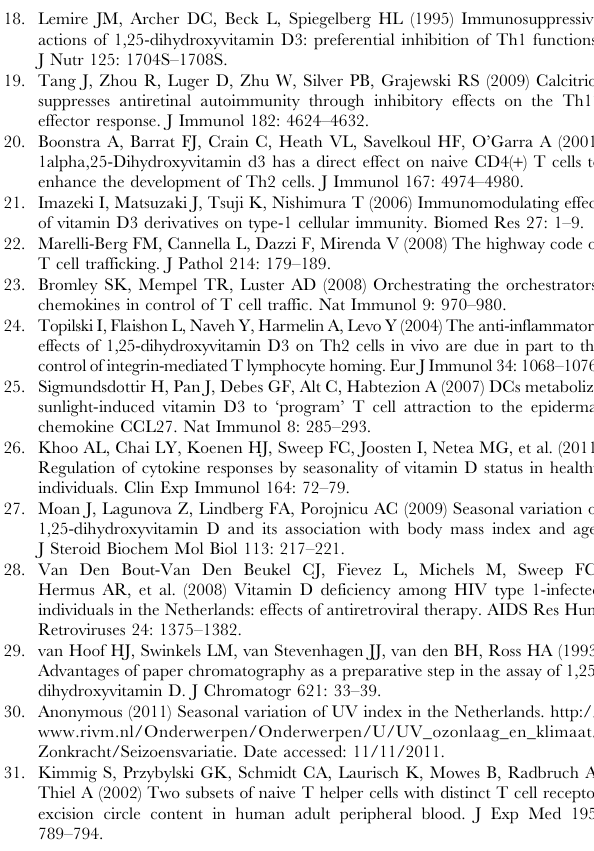
Figure S1 Gate setting for CD4 + and CD8 + T cells gated on CD45 + cells; and CD4 + CD45RA + T cells, CD4 + CD45RO + T cells and CD4 + CD25 hi CD127 2 regula- tory T cells gated on CD4 + T cells. Dotplots show surface staining for markers performed on whole blood. (EPS)